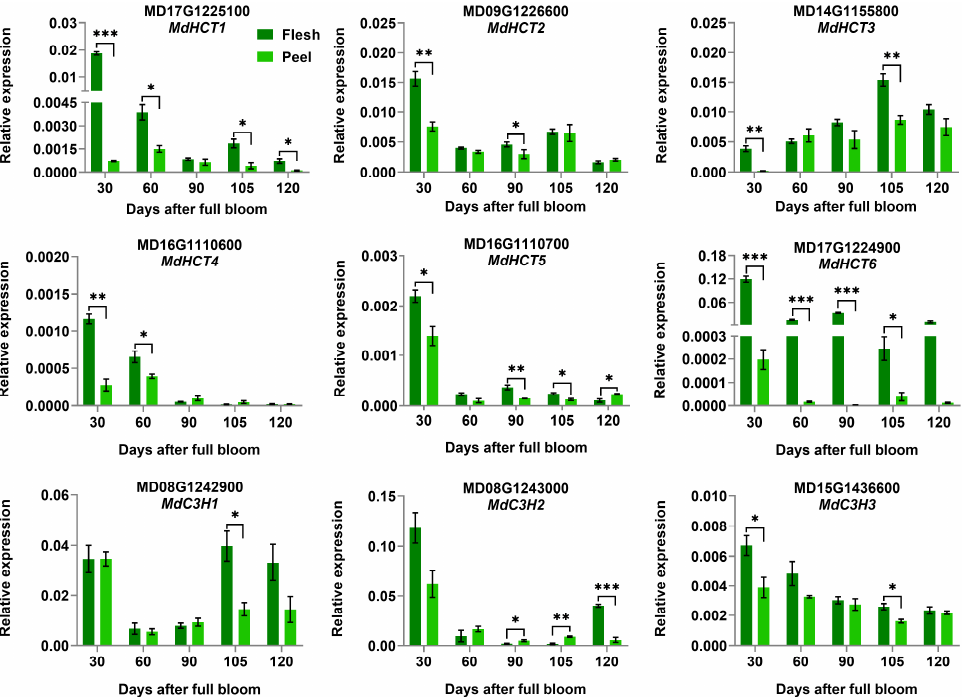
Figure 5. Quantitative expression analysis of candidate genes related to chlorogenic acid biosynthesis during fruit development in ‘Huashuo’ apples. Dark green columns and light green columns represent the expression levels of the genes in the flesh and the peel of the fruit, respectively. Error bars indicate standard errors from three biological replicates. (* p < 0.05, ** p < 0.01, *** p < 0.001).